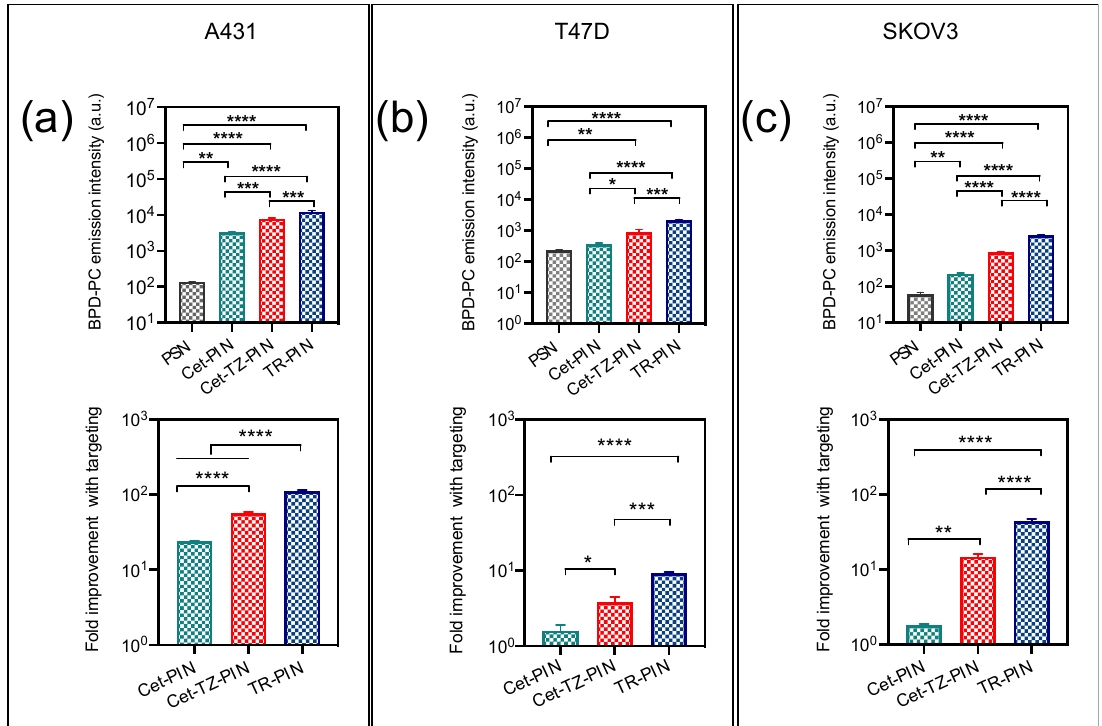
Figure 3. Triple-receptor targeting enhances the TR-PIN binding to cells expressing corresponding receptors. Cellular binding and corresponding BPD-PC emission intensities of PINs using flow cytometry analysis. Triple-receptor-targeted PINs (TR-PINs) exhibiting a significant improvement in binding with TR-PINs to ( a ) A431 cells, ( b ) T47D cells, and ( c ) to SKOV-3 cells in comparison with Cet-targeted PINs (Cet-PINs) or Cet- and TZ-targeted PINs (Cet-TZ-PINs) (mean ± S.E.M.; n = 3; one-way ANOVA with a Tukey post-test; **** = p ≤ 0.0001; *** = p ≤ 0.001; ** = p ≤ 0.01; * = p ≤ 0.05). Cellular binding of Cet-PINs to A431 cells (24-fold improvement with targeting) was higher as